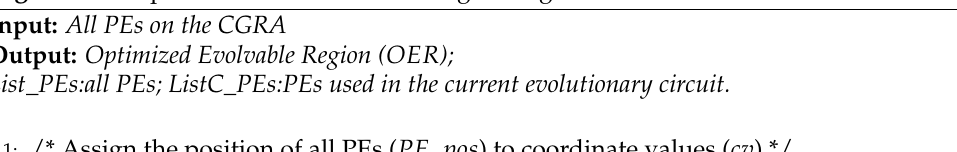
Algorithm 1 Optimization of Evolvable Region